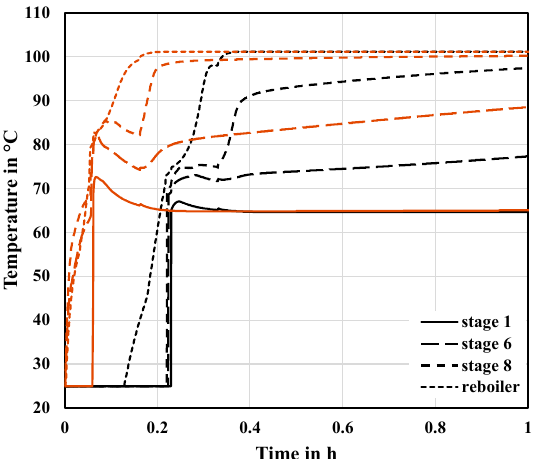
Figure 6. Temperature profiles during start-up of a segment for selected stages and the reboiler for BC segmented (black) and case C1 (red).